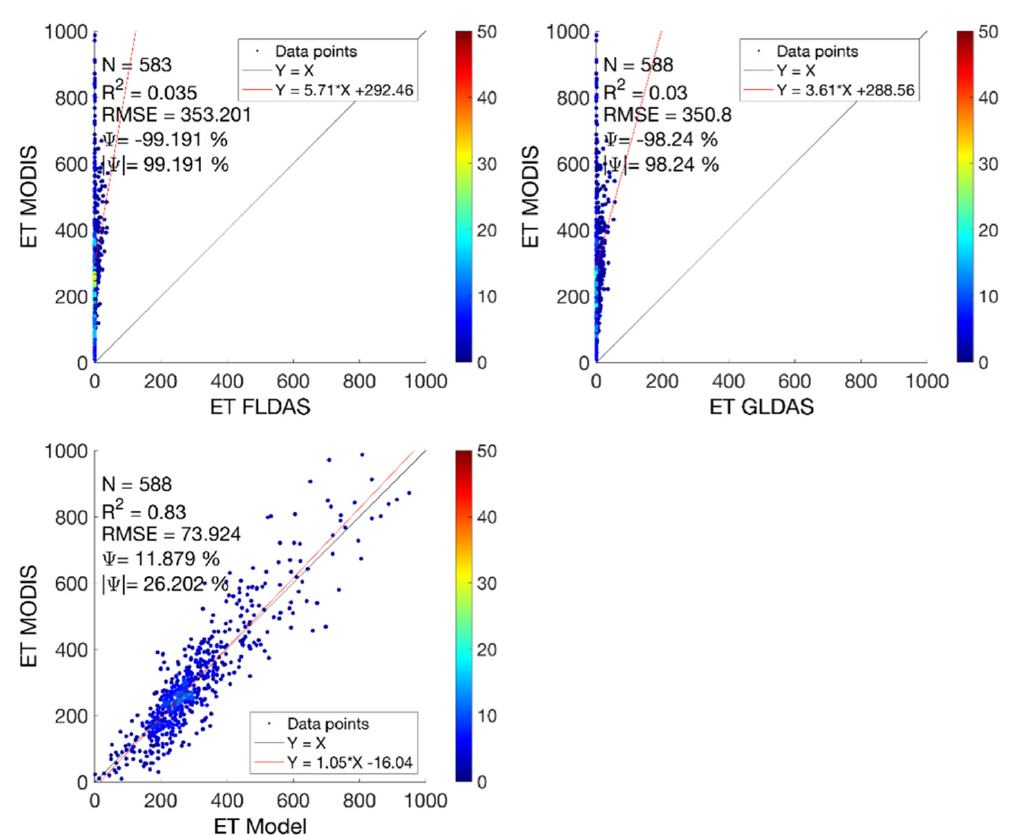
Figure 13. Comparisons of MODIS ET versus ET values obtained from FLDAS, GLDAS and the proposed model using testing data in Egypt. The solid black and red lines represent the one to one line and regression line, respectively.